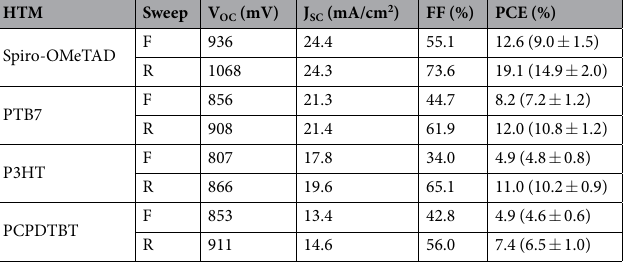
Table 1. Photovoltaic parameters of the devices characterized in this study under standard 1 sun illumination. Each value corresponds to the champion cell. The PCE value between parentheses is the average of eight solar